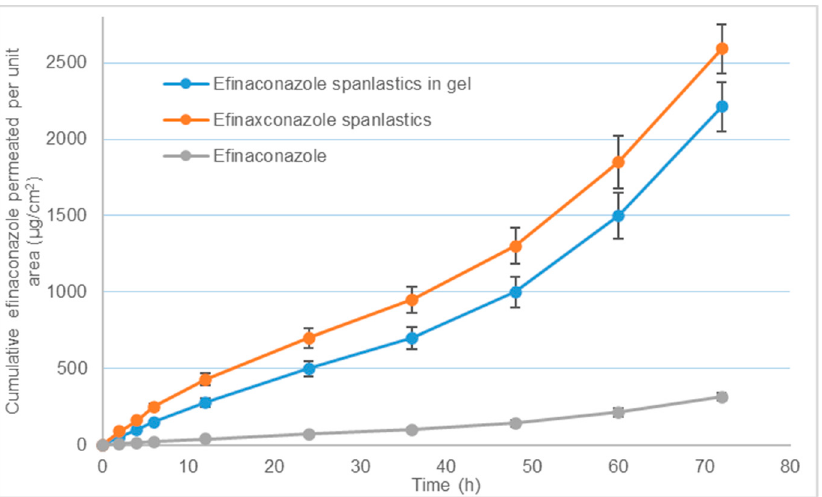
Figure 5. Release of efinaconazole vs. time profiles of pristine drug dispersion, spanlastics, and spanlastics dispersed in carbopol gel. Plotted values are the mean of six determinations and error bars represent standard deviation.